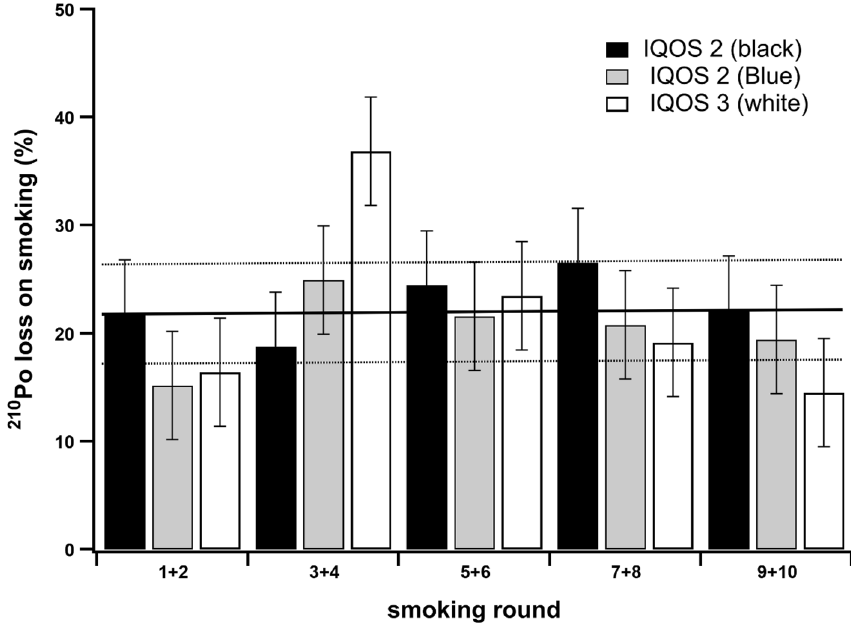
Figure 1. Percentage (%) of 210 Po lost from the tobacco after smoking a Heets cigarette using two different IQOS generations. 10 cigarettes were smoked and grouped by two before analysis to improve sensitivity. Results from the IQOS 2 are in black and in gray and results from IQOS 3 are in white.